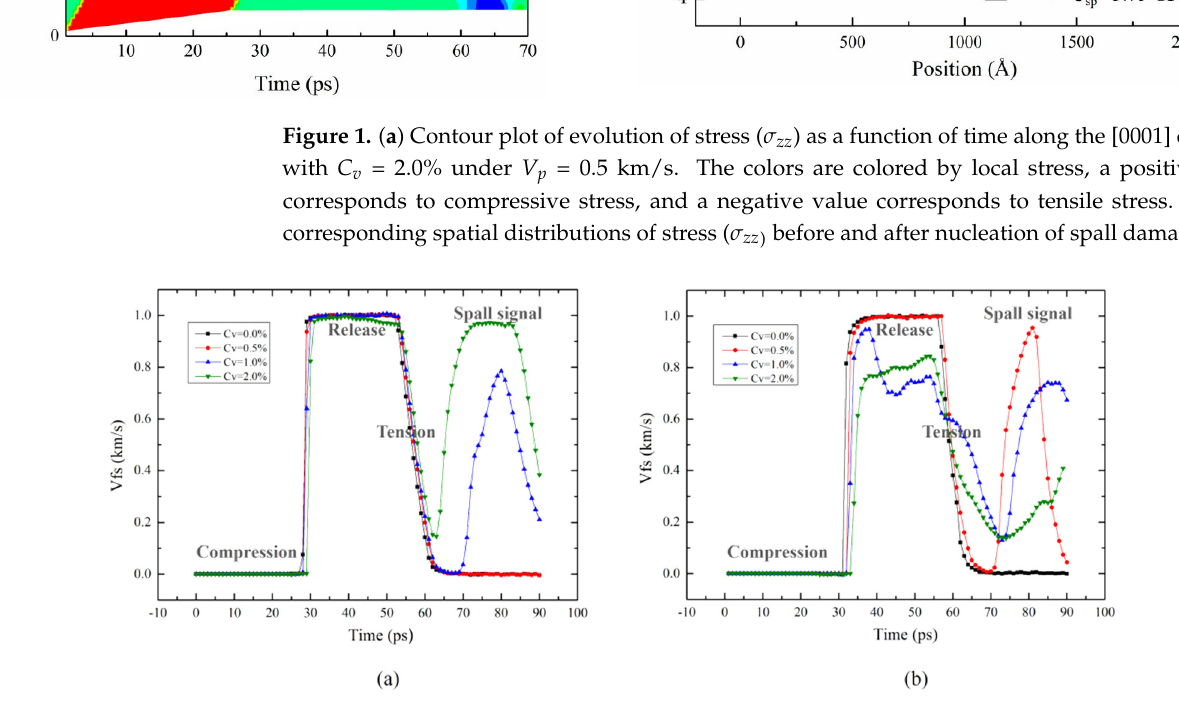
Figure 2. Free surface velocity evolution history with different C v along different shock directions: ( a ) [0001] and ( b ) [10 – 10] under V p = 0.5 km/s.